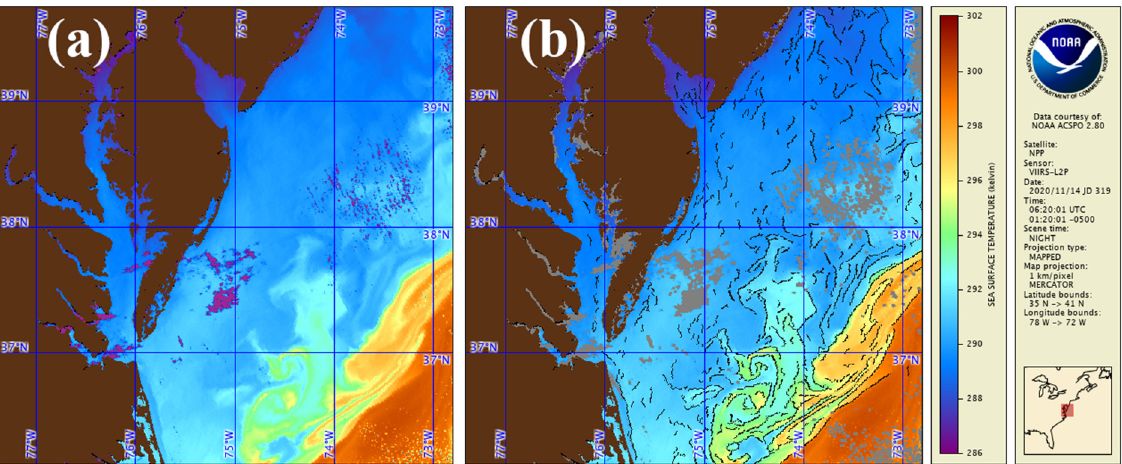
Figure 4. ACSPO NPP VIIRS nighttime L2P SST over the Chesapeake Bay on 14 November 2020: ( a ) all-sky imagery (no ACSM overlaid); ( b ) the same scene but with the ACSM V2.80 applied (gray overlay) and thermal fronts overlaid (in black). Land is rendered in brown. Images are from the NOAA ACSPO Regional Monitor for SST online system (ARMS) [19].